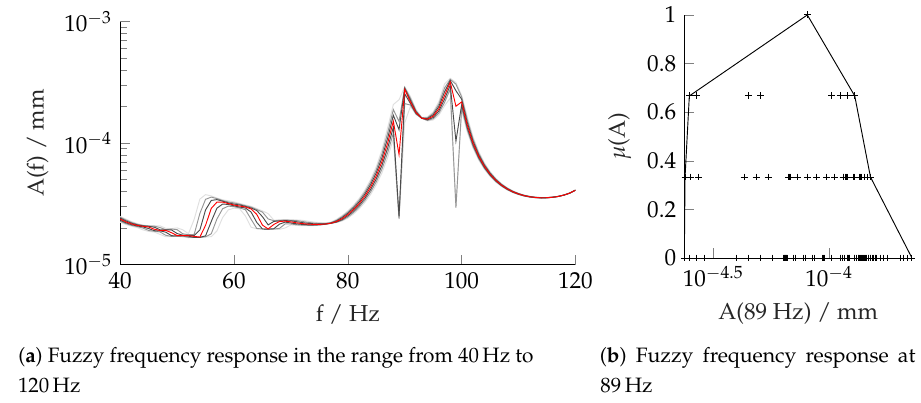
Figure 9. A detailed look on the fuzzy frequency response in the range from 40Hz to 120Hz